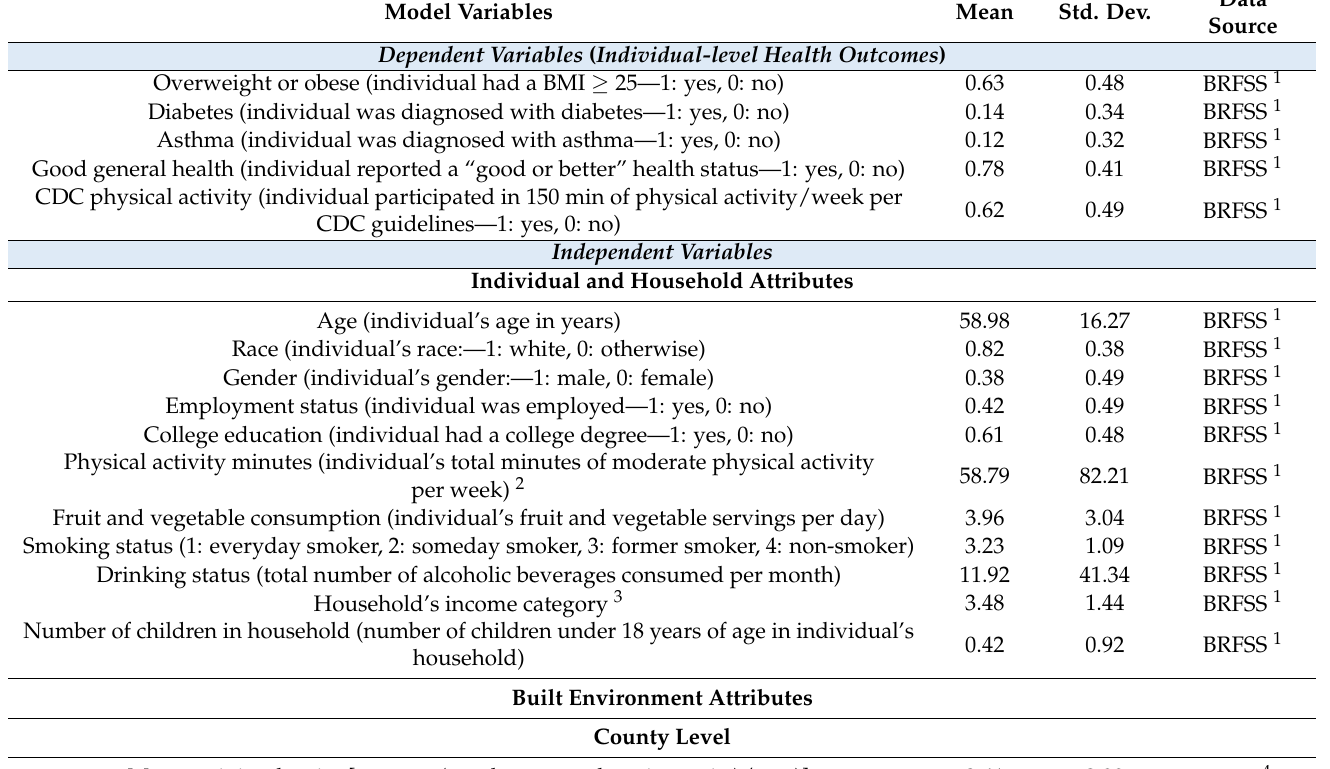
Table 1. Health outcome models’ variables. Model Variables Std. Dev.